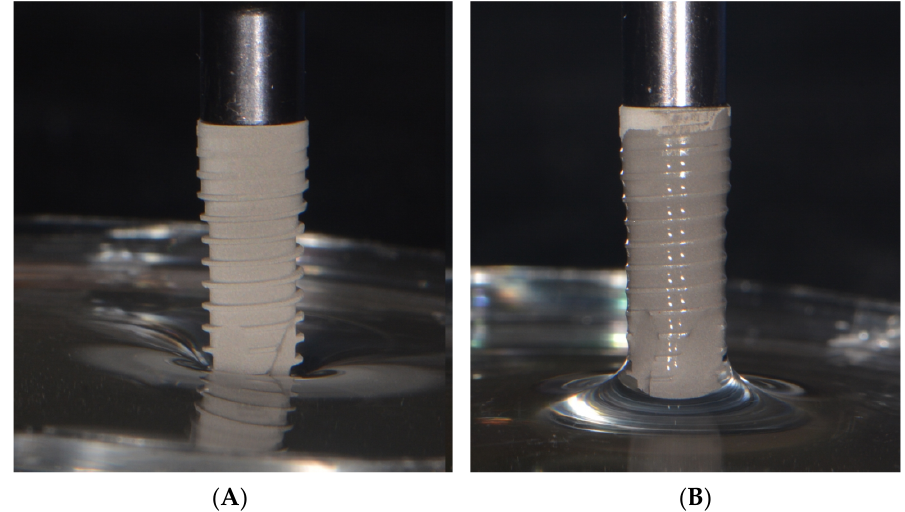
Figure 1. ( A ) Laboratory image of a hydrophobic implant surface in the non-irradiated group. ( B ) Laboratory image of hydrophilic changes in the UV irradiation group.